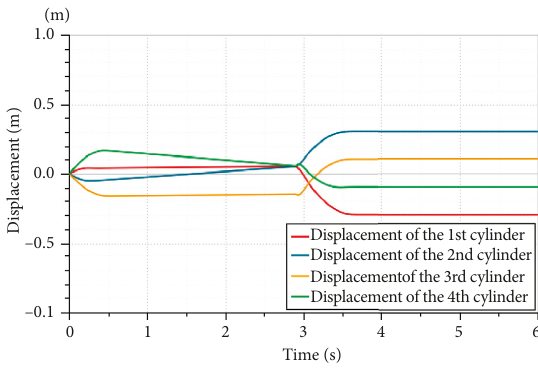
Figure 14: Displacement curve of the cylinder